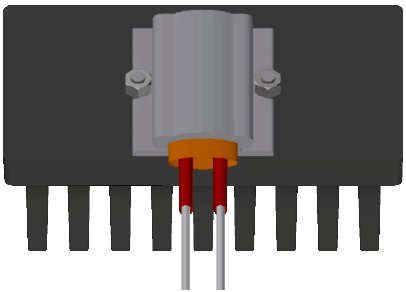
Figure 4. Heater placed in the middle of the heat sink. The cooling efficiency results were obtained via a thermocouple of type K placed inside the heater, as seen in Figure 5.